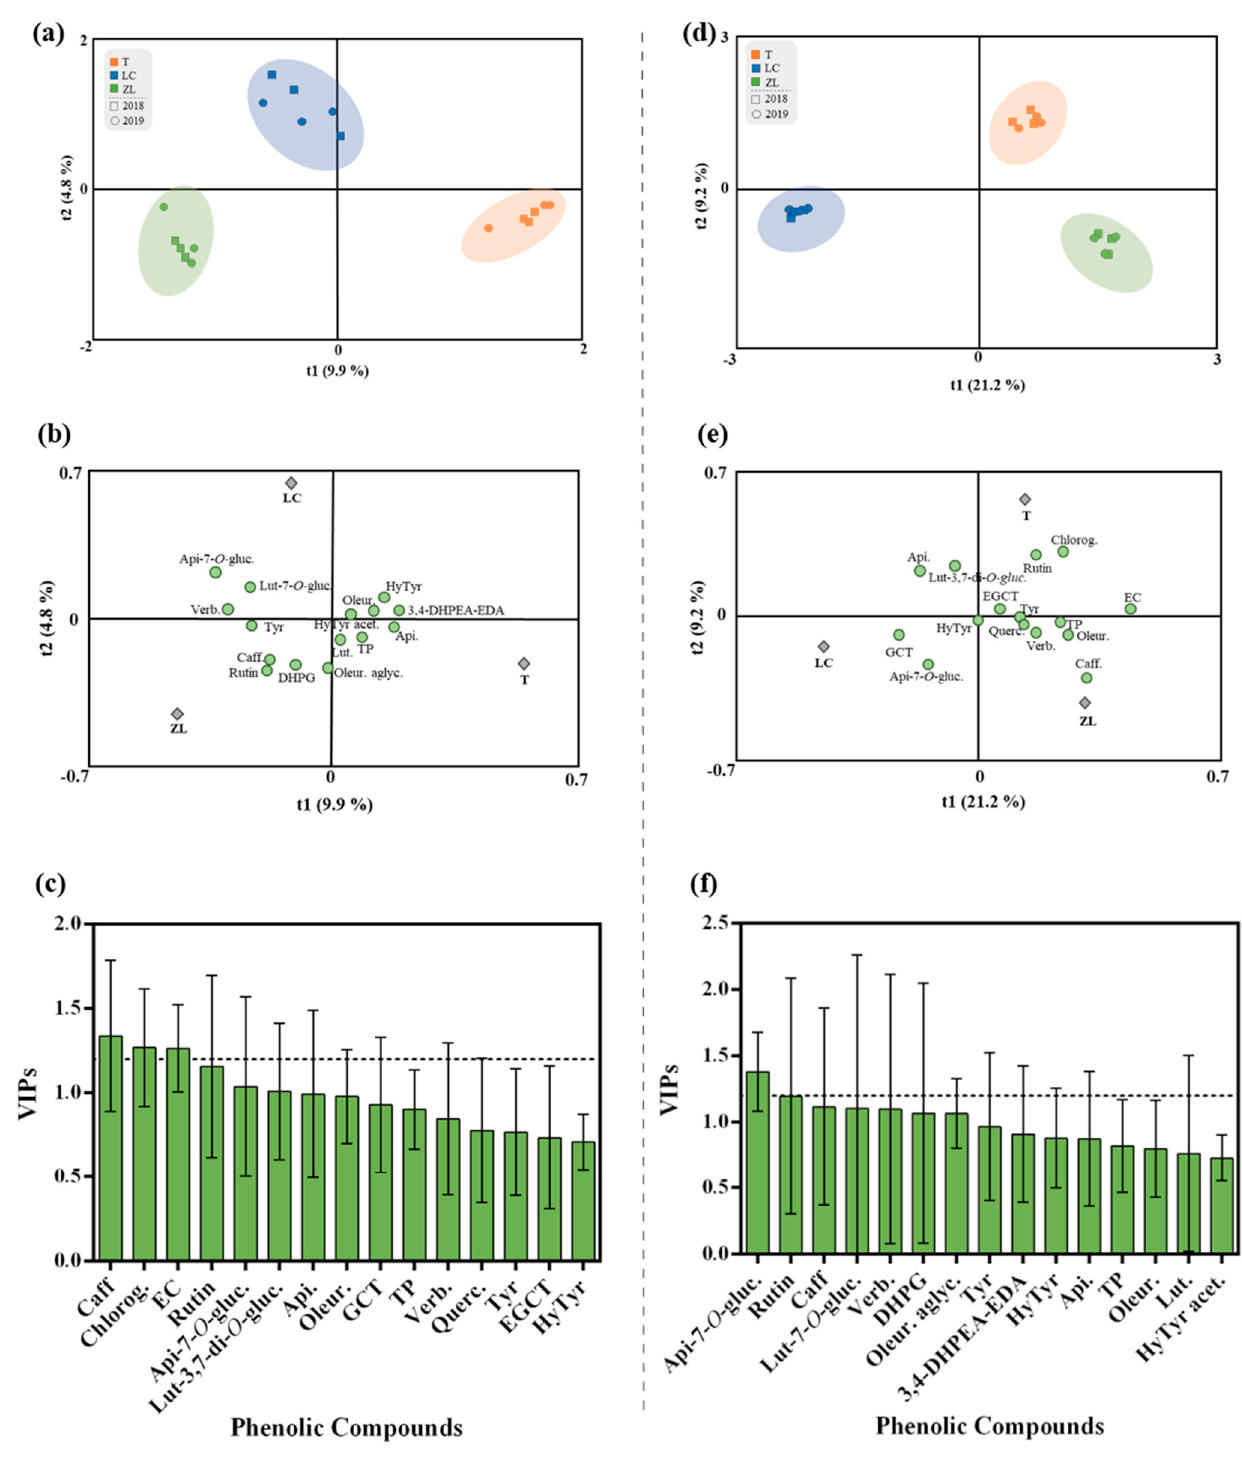
Figure 2. ( a – c ) OPLS-DA of olive fruit and ( d – f ) olive oil phenolic compounds, irrespective of the year. ( a and d ) Scores plot and ( b and d ) loadings plot of the first two factors of the OPLS-DA model built with the phenolic profile of the olive oil according to the soil treatment. ( c , f ) Phenolic compounds ranked by VIP scores. Caffeic acid (Caff), chlorogenic acid (Chlorog), rutin, luteolin-3,7-di- O -glucoside (Lut-3,7-di- O -gluc.), epicatechin (EC), apigenin-7- O -glucoside (Api-7- O -gluc), apigenin (Api), oleuropein (Oleur), gallocatechin (GCT), total phenols (TP), verbascoside